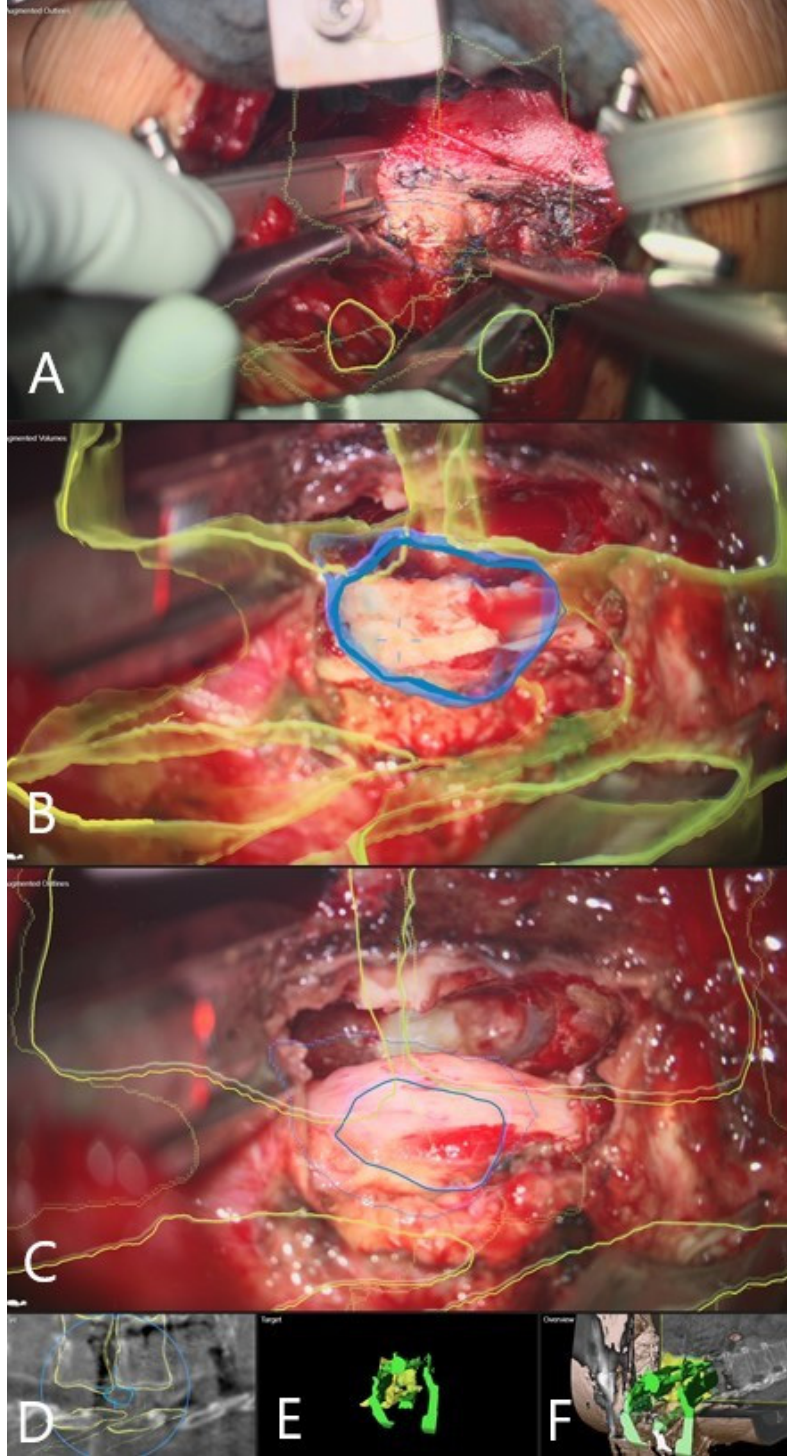
Figure 9. Same patient as in Figure 8 (patient no. 15). Microscope-based AR visualizing the outline of the herniated disc and vertebra Th 7 and 8. ( A ) At the beginning of the discectomy. ( B ) During the course of discectomy. ( C ) Following drilling out the sequestrated disc with exposure of the dural sack with ( D ) probe’s-eye view; ( E ) target view visualizing the displayed AR objects. ( F ) A 3D rendering of the iCT images, illustrating how video frame is placed in relation to the image data.